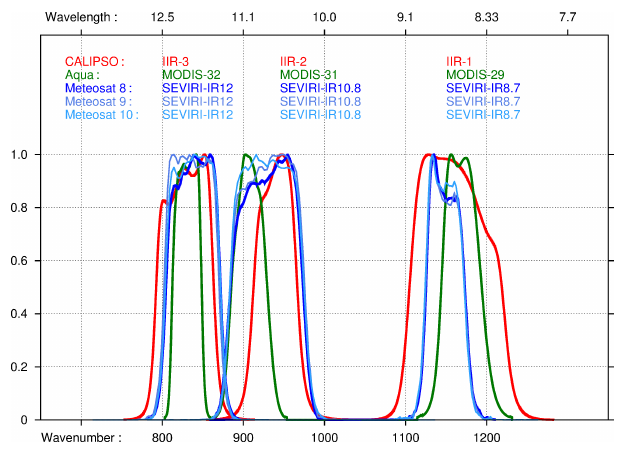
Figure 2. IIR/CALIPSO (red), MODIS/Aqua (green), and SE- VIRI/Meteosat 8, 9, 10 (navy blue, medium blue, light blue) in- strument spectral response functions against wavelength in microns (top x axis) and wavenumber incm − 1 (bottom x